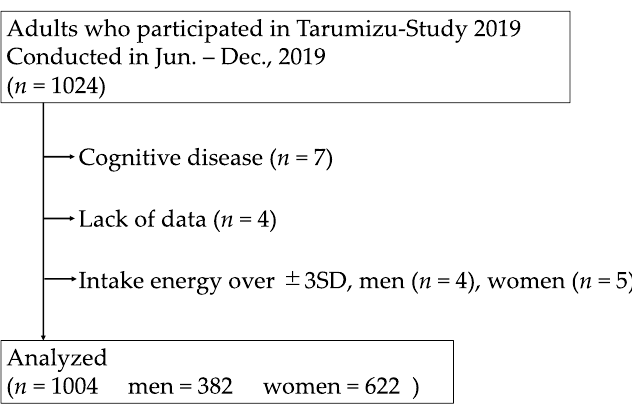
Figure 1. Flowchart for inclusion of study participants.